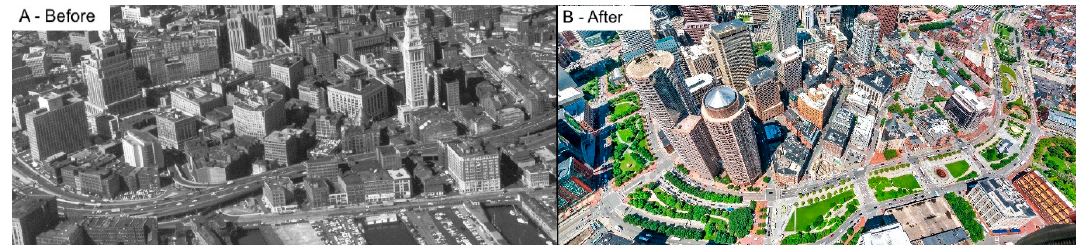
Figure 6. ( A ) The Central Artery highway running through the city in 1962. ( B ) Rose Kennedy Greenway in 2017 following depression of the Central Artery. Photo A: Reproduced with permission from the Massachusetts State Archives. Photo B: Reproduced with permission from the Rose Kennedy Greenway Conservancy, photo: © Kyle Klein